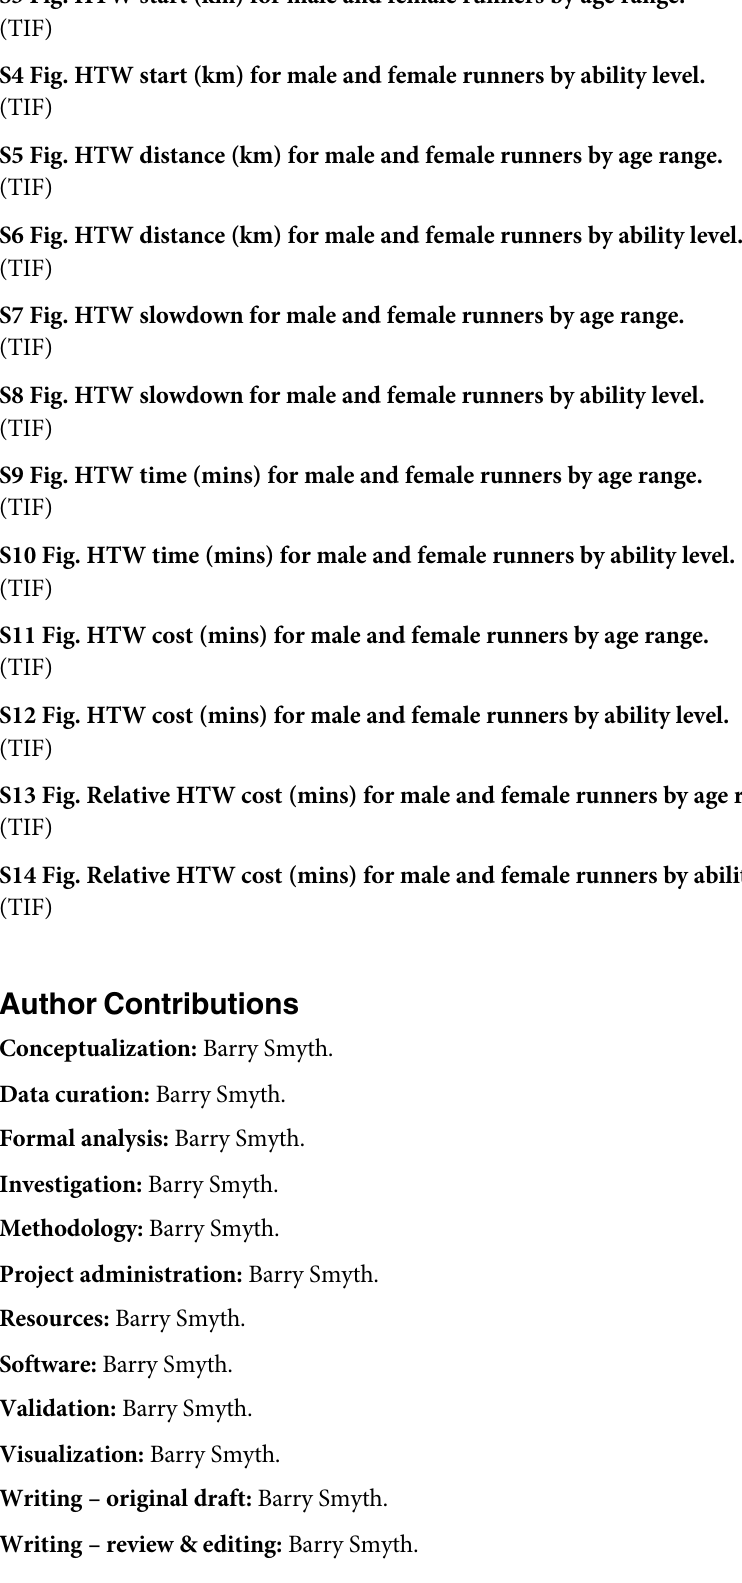
S3 Fig. HTW start (km) for male and female runners by age range. (TIF) S4 Fig. HTW start (km) for male and female runners by ability level. (TIF) S5 Fig. HTW distance (km) for male and female runners by age range. (TIF) S6 Fig. HTW distance (km) for male and female runners by ability level. (TIF) S7 Fig. HTW slowdown for male and female runners by age range. (TIF) S8 Fig. HTW slowdown for male and female runners by ability level. (TIF) S9 Fig. HTW time (mins) for male and female runners by age range. (TIF) S10 Fig. HTW time (mins) for male and female runners by ability level. (TIF) S11 Fig. HTW cost (mins) for male and female runners by age range. (TIF) S12 Fig. HTW cost (mins) for male and female runners by ability level. (TIF) S13 Fig. Relative HTW cost (mins) for male and female runners by age range. (TIF) S14 Fig. Relative HTW cost (mins) for male and female runners by ability level.